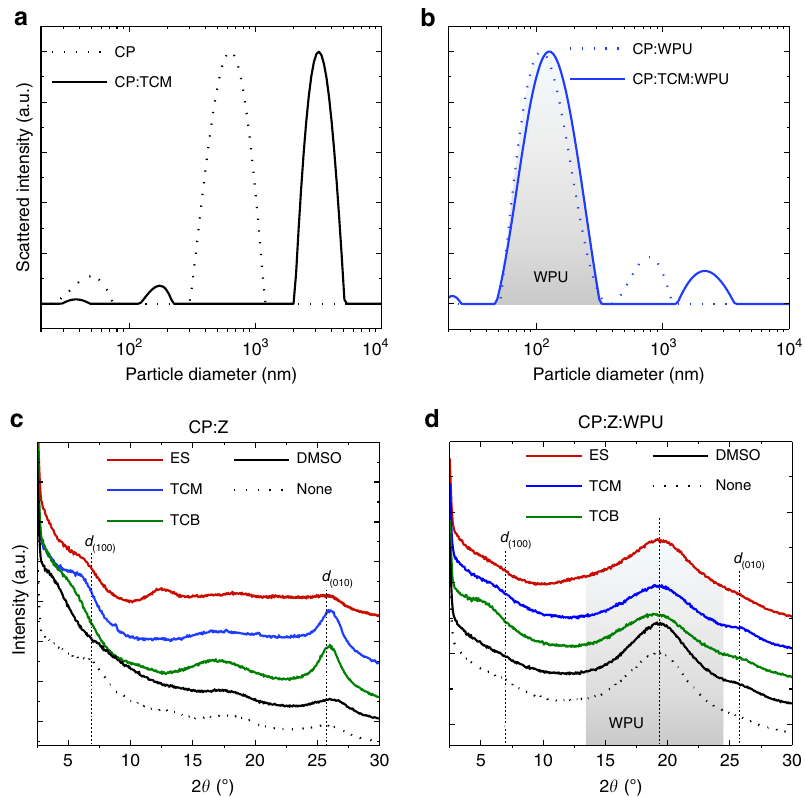
Fig. 4 Structural changes in the dispersion and fi lm states by the addition of IL. Dynamic light scattering studies on particle size distribution of a CP and b CP-WPU composite dispersions, both with and without TCM. The size distribution of WPU was fi lled with gray color. XRD patterns of c CP and d CP- WPU composite fi lms, both with and without a different type of ILs or DMSO (Z). The diffraction peak of WPU was fi lled with gray color. d (100) and d (010) indicate the lamella stacking distance and the π – π stacking distance detected in pristine PEDOT:PSS, respectively. Composition ratio, CP:IL = 15:25 or CP:IL: WPU = 15:25:85. w/w for all samples.